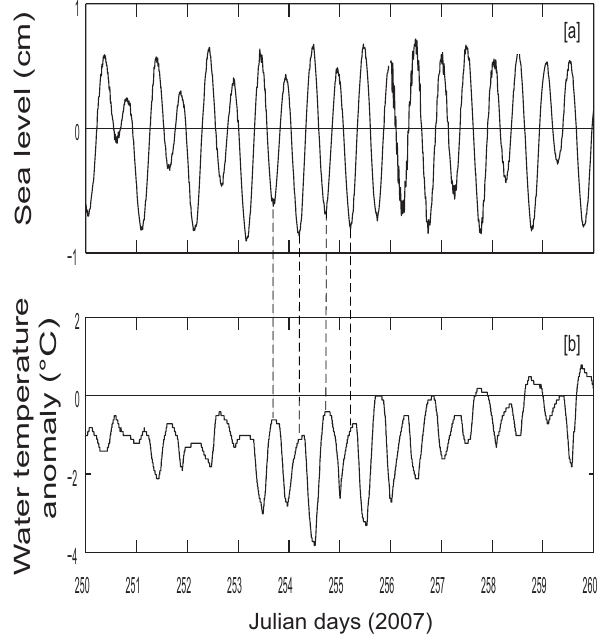
Fig. 9. Sea-water parameters observed at Verem, Goa during event E2 of 12 September 2007 due to Sumatra earthquake ( M w = 8.4). (a) Sea level (cm) and (b) measured water temperature anomaly ( ◦